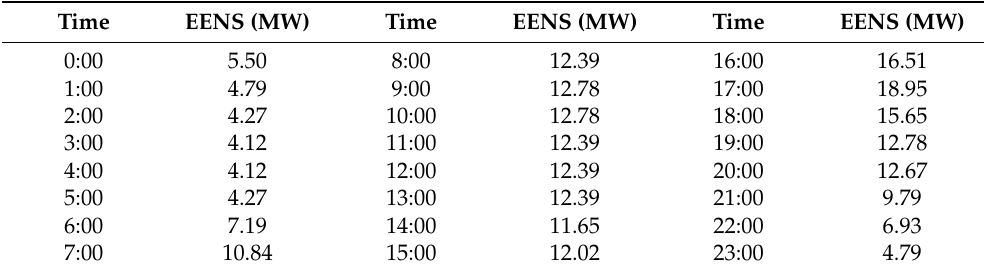
Table 4. Expected loss of energy.